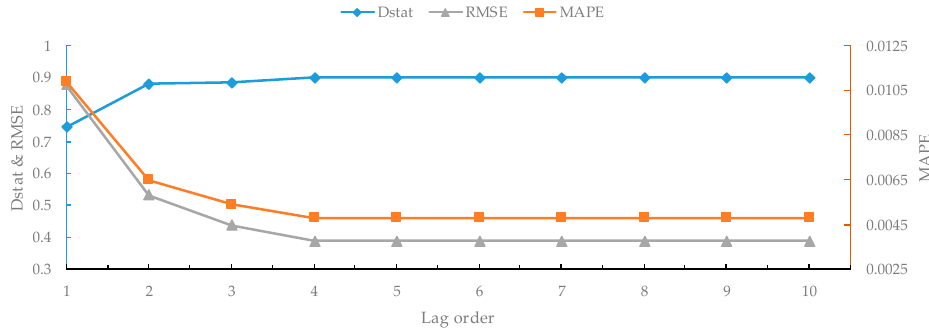
Figure 6. The impact of lag order on WTI crude oil prices with one-step-ahead forecasting.